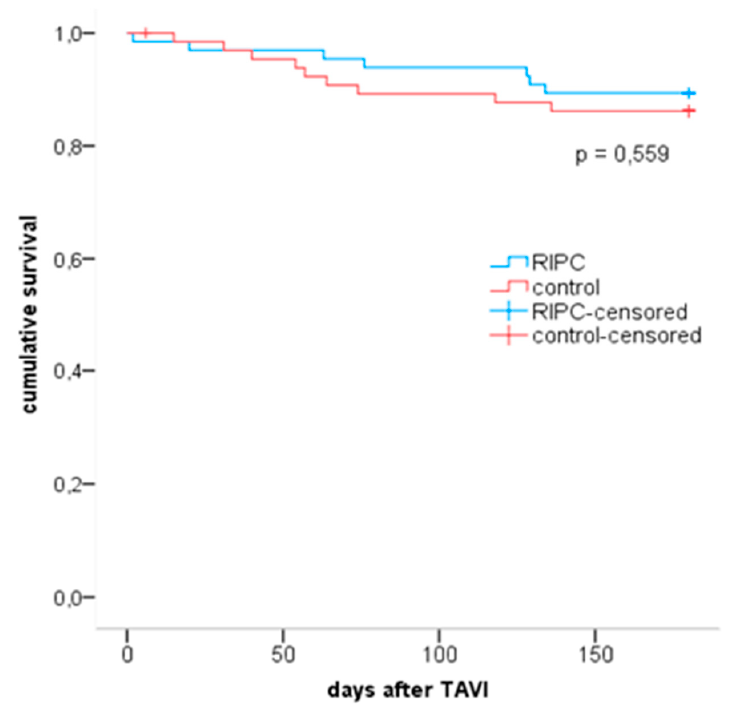
Figure 6. Kaplan–Meier curves for RIPC and matched control group. Blue line shows RIPC group, red line shows control-group. Numbers at risk: time point 0—n = 66 for RIPC and controls; time point 6 months—n = 59 [RIPC], n = 57 [controls]. RIPC = remote ischemic preconditioning; TAVI = transcatheter aortic valve implantation.